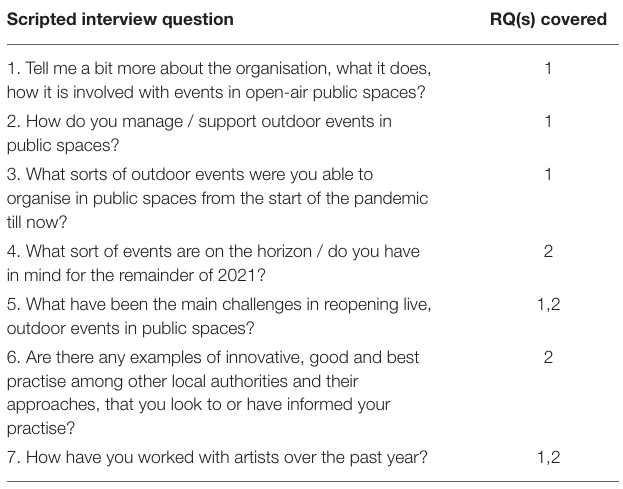
TABLE 1 | Correspondence between scripted interview questions and over-arching study research questions. Scripted interview